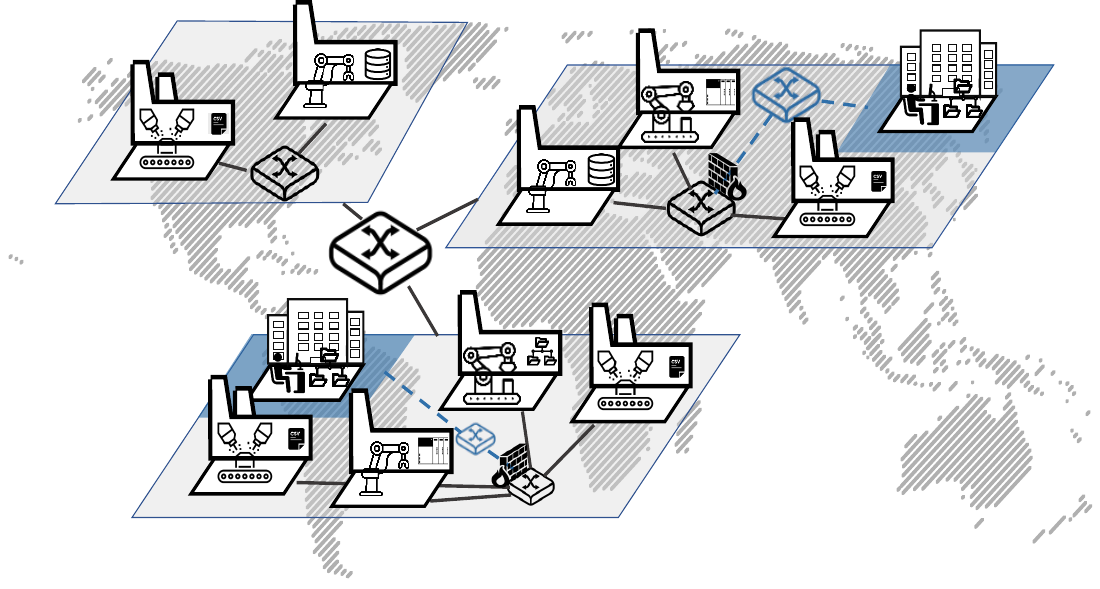
Figure 1. Scenario of multiple factories and their two separate network zones, production (grey) and office